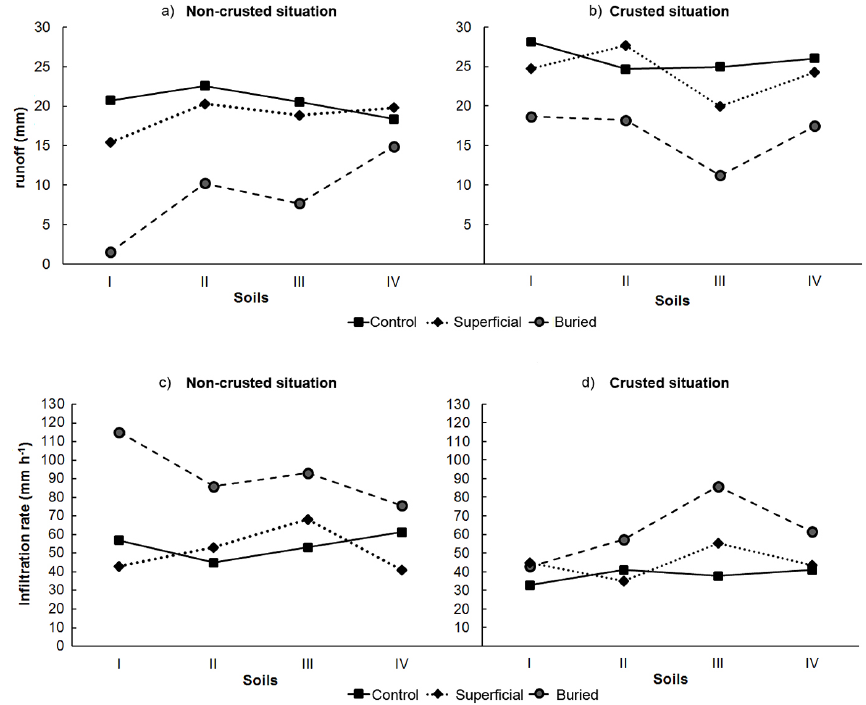
Figure 2. Behavior of hydrological variables in function of the studied factors: runoff (a) without crust, (b) with crust, and infiltration rate (c) without crust, (d) with crust.